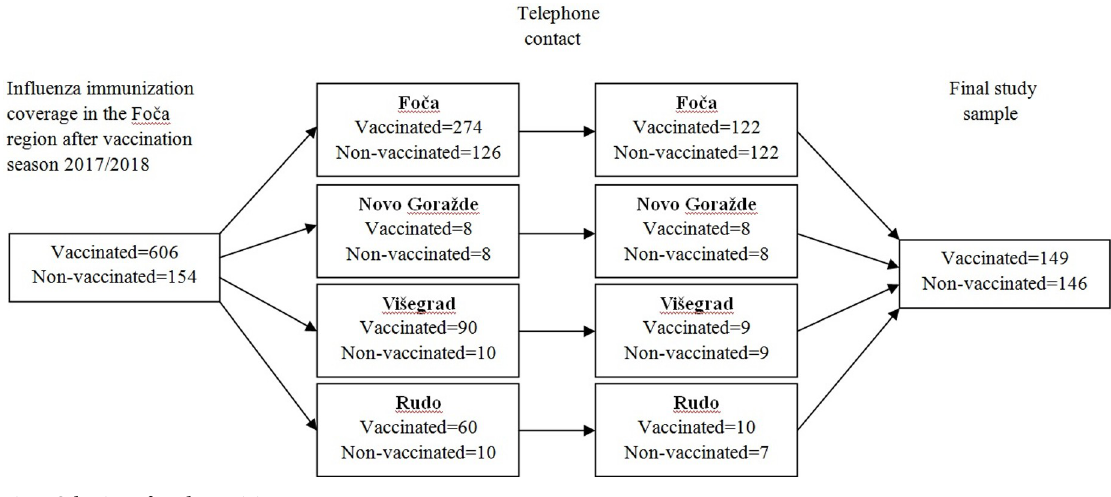
Fig 1. Selection of study